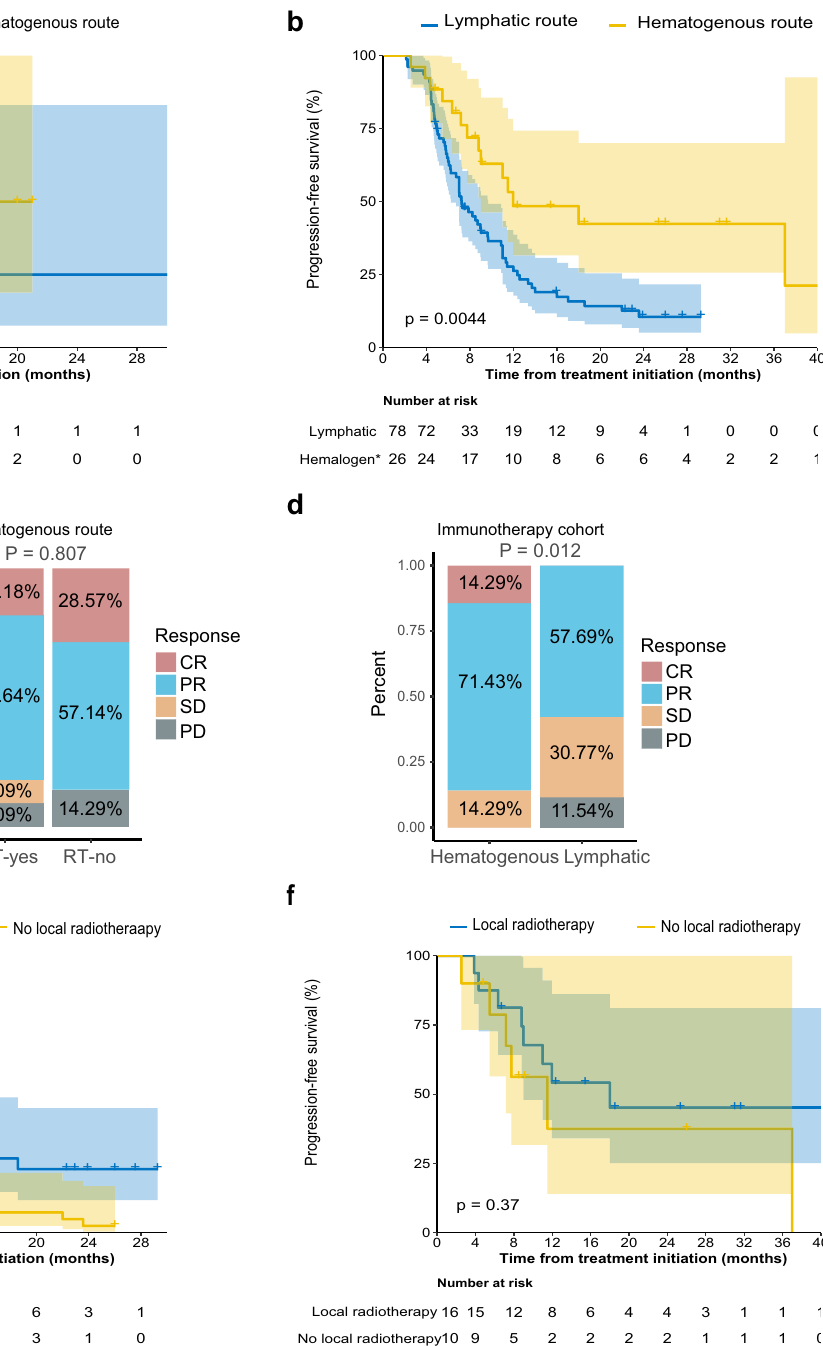
locoregional radiation therapy and those who did not in the primary diagnosed metastatic NPC cohort in the lymphatic (left) and hematogenous (right) models. RT: radiation therapy. d Bar plot showing the different response rates to combi- nation immunotherapy between the lymphatic and hematogenous groups in the immunotherapy NPC cohort. e , f Kaplan ‒ Meier curves of PFS between metastatic patients who received local radiotherapy and those who did not receive local radiotherapy in patients with metastases emerging via the lymphatic route ( e ) or the hematogenous route ( f ). The data are shown along with 95% con fi dence intervals. The log-rank test was used to calculate the P value